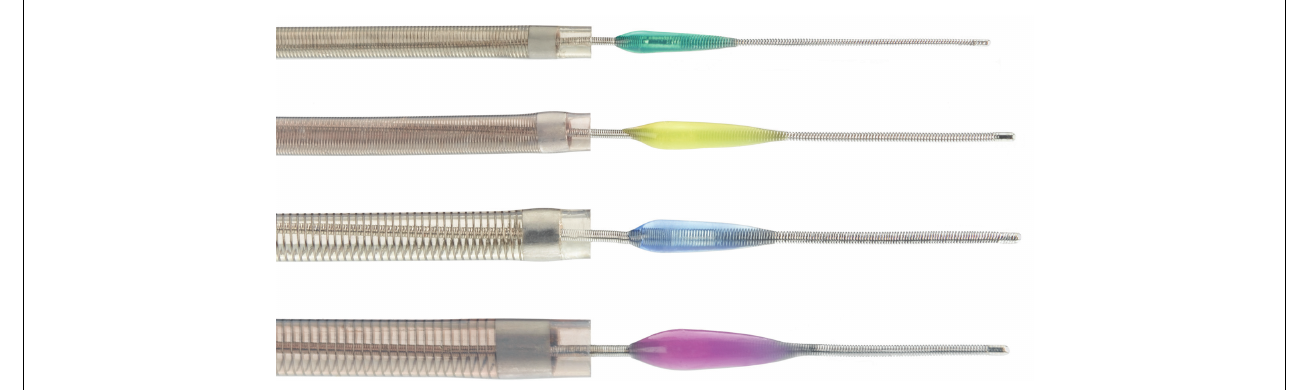
FIGURE 2 | Penumbra microcatheter and separator system (with permission, Penumbra Inc.) .